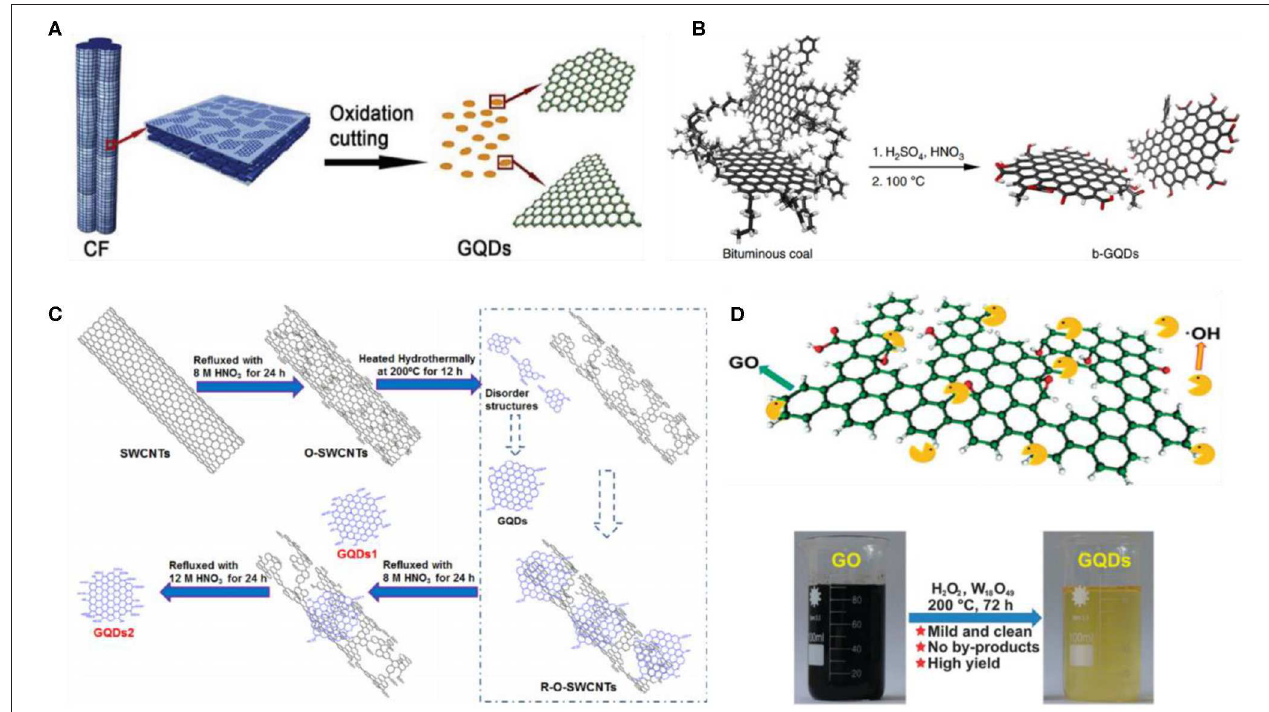
FIGURE 2 | Diagrammatical representation of the acidic exfoliation of different carbon-based precursor such as (A) carbon fiber (CF); reproduced from Peng et al. (2012) with permission from the American Chemical Society. (B) Bituminous coal, reproduced from Ye et al. (2013) with permission from the Nature Publishing Group. (C) Single-walled CNTs (SWCNTs), reproduced from ( Dong et al., 2013) with permission from Elsevier. (D) GO; reproduced from Zhu et al. (2015a) with permission from the Royal Society of